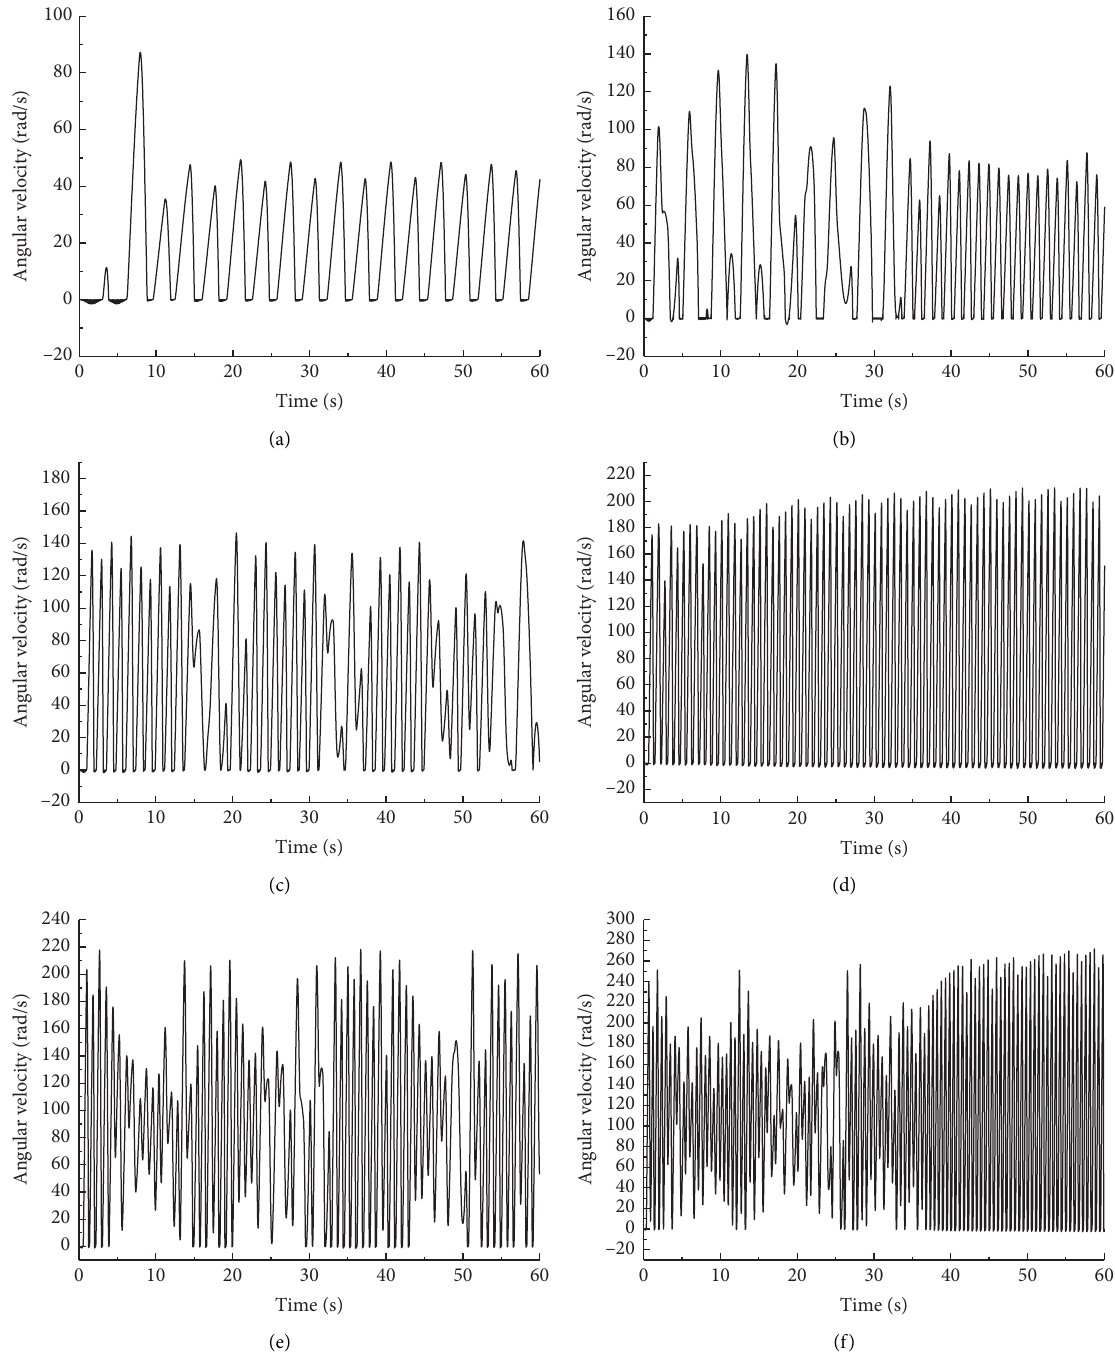
Figure 6: Angular velocity for various driving velocities: (a) 17.9r/min, (b) 35.7 r/min, (c) 53.6r/min, (d) 74.4r/min, (e) 89.3r/min, and (f) 107.1